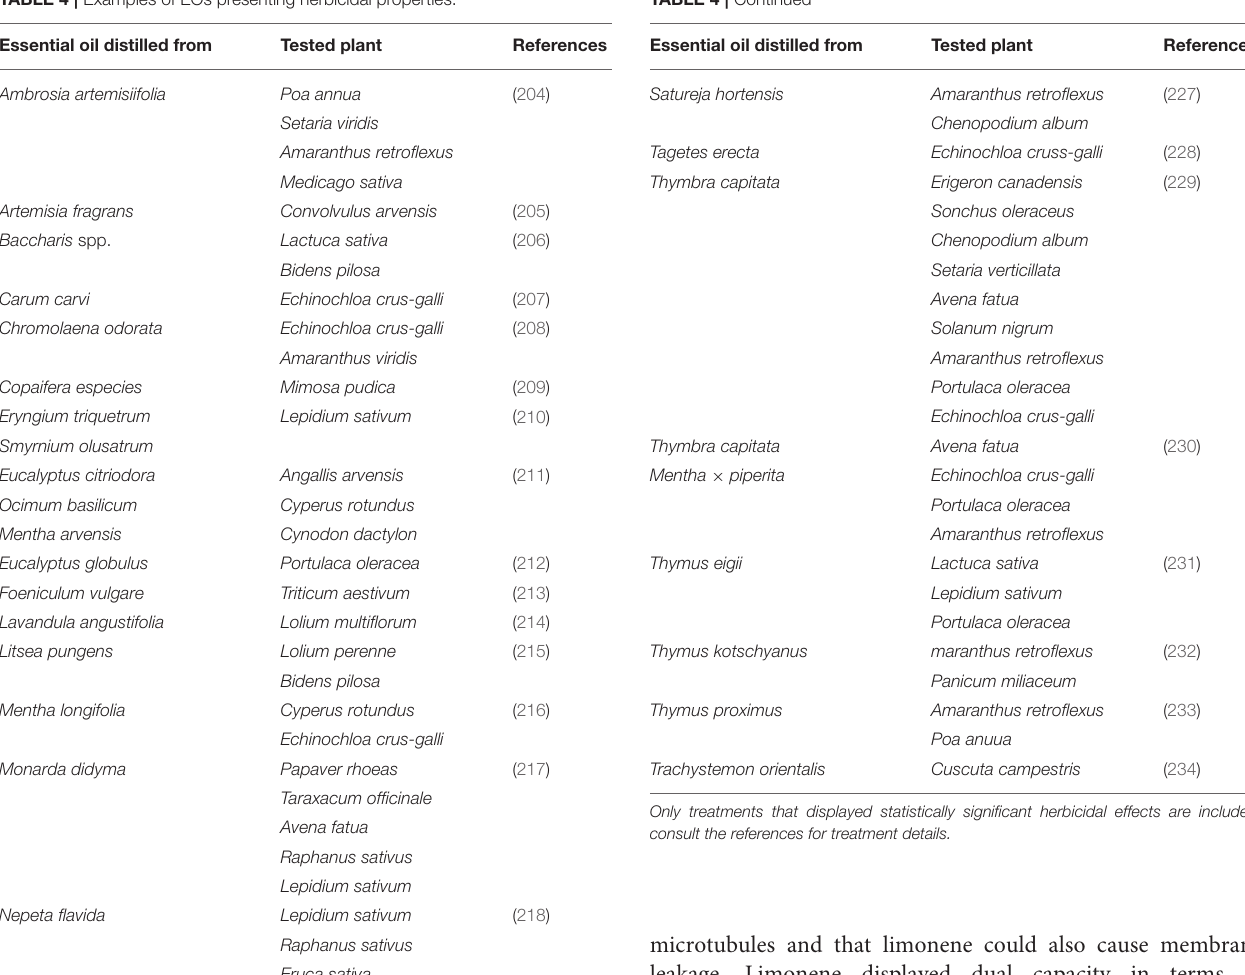
TABLE 4 | Examples of EOs presenting herbicidal